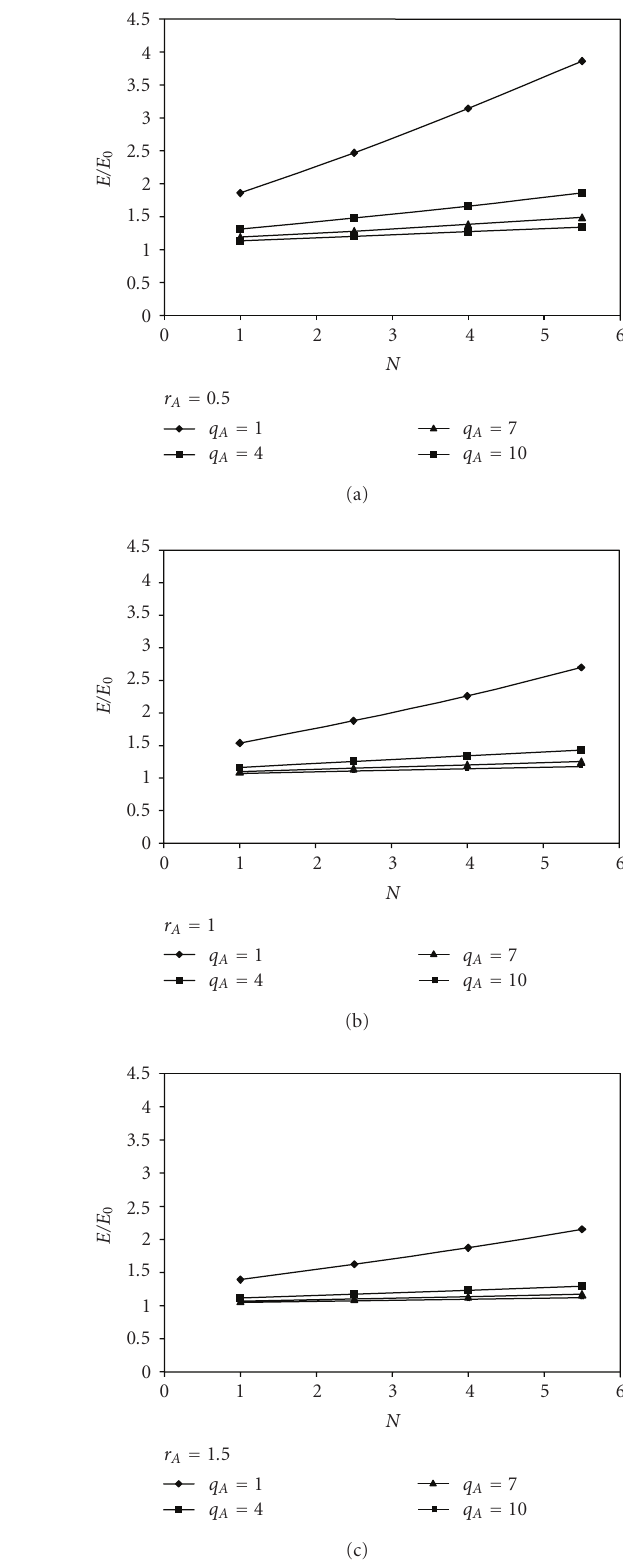
Figure 3: Enhancement factors as a function of N for the SO 2 – slurry system. Enhancement factors as a function of N Mg(OH) 2 slurry system. Enhancement factors as a for the SO 2 –Mg(OH) 2 slurry function of N for the SO 2 –Mg(OH) 2